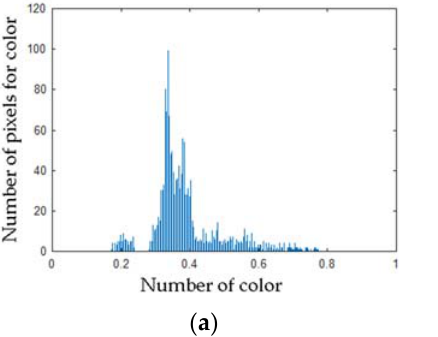
Figure 16. Values of the matrix V for the thermal image of the healthy angle grinder (indicated by the green line).